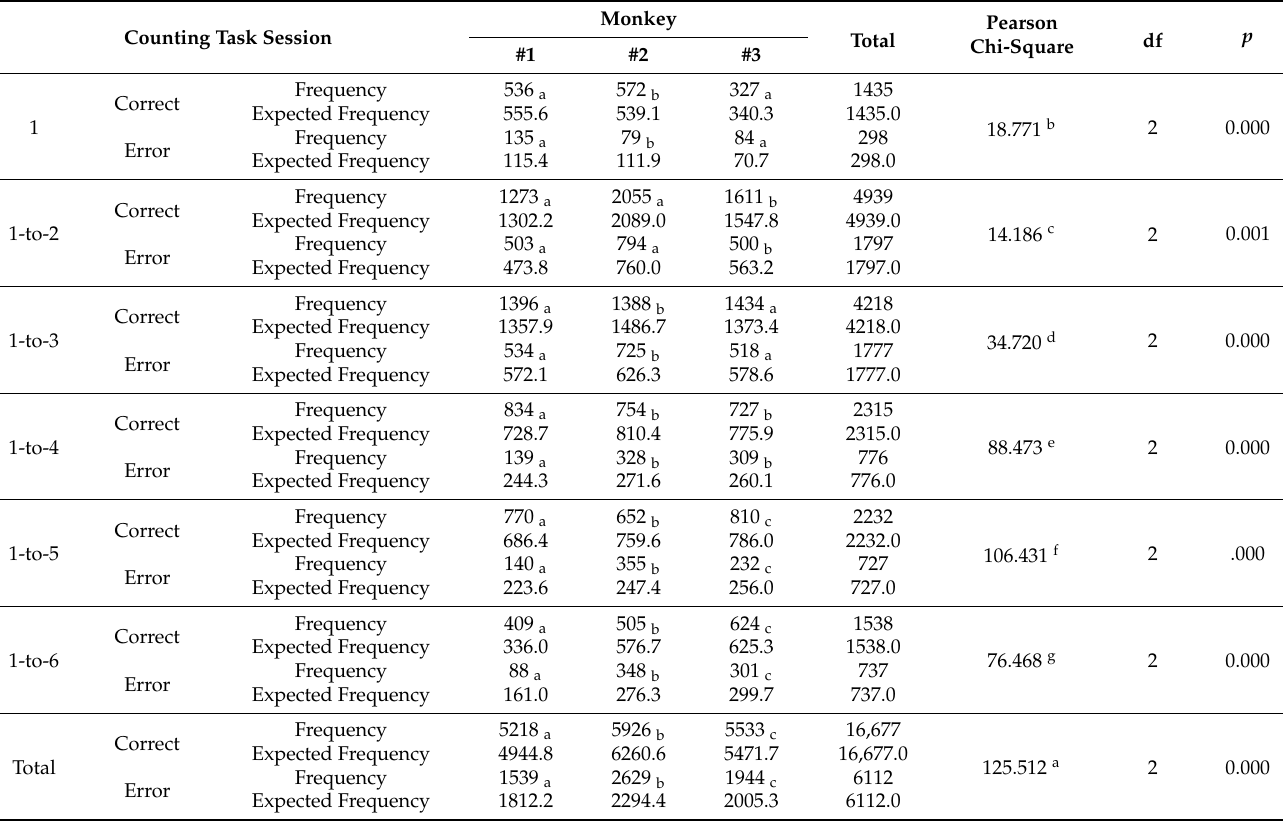
Table 2. Differences among the three monkeys in counting task